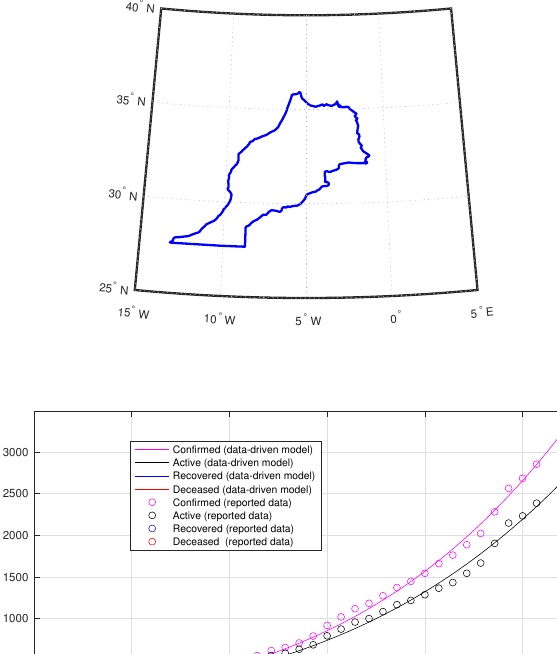
Confirmed (data-driven model) Active (data-driven model) Recovered (data-driven model) Deceased (data-driven model) Confirmed (reported data) Active (reported data) Recovered (reported data) Deceased (reported data)